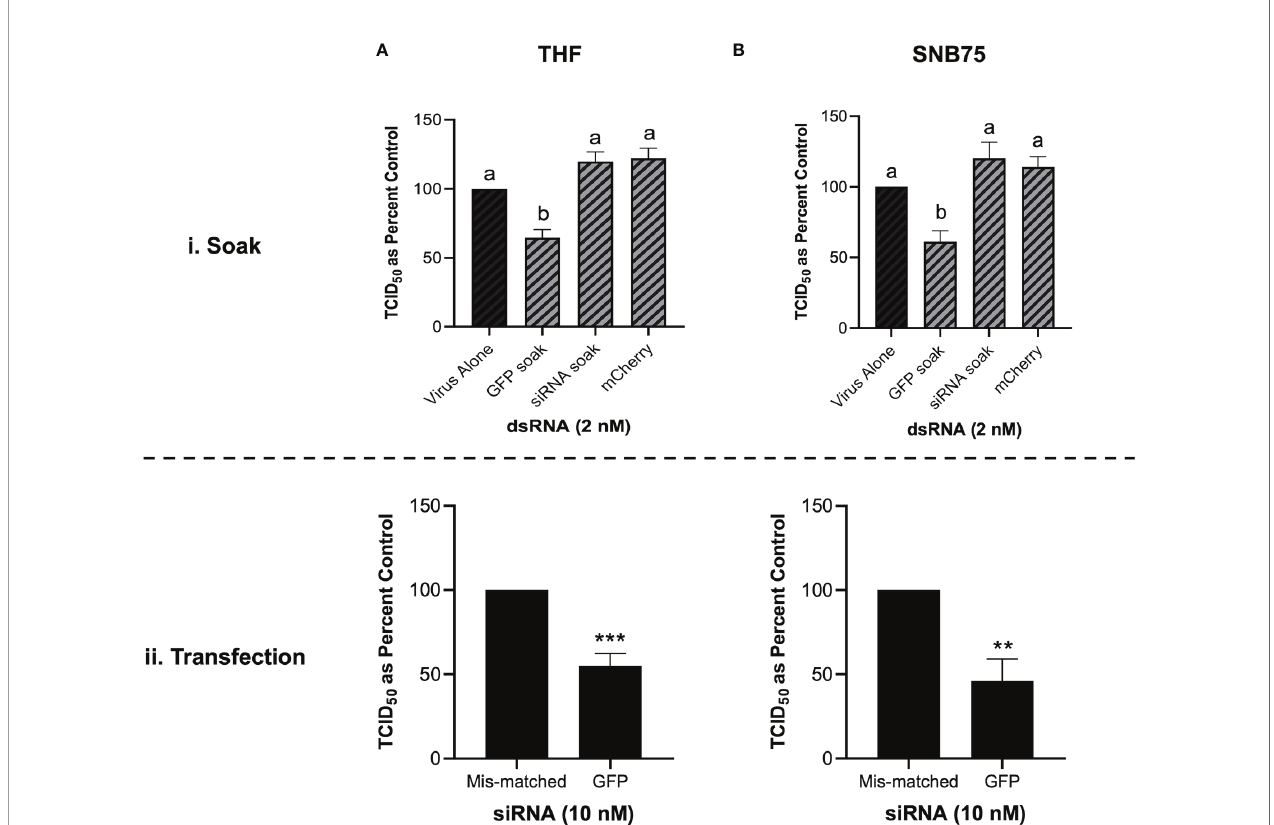
FIGURE 6 | Soaking is suf fi cient for long dsRNA-induced antviral effects but not siRNA. THF (Ai) and SNB75 (Bi) were pre-soaked for 2h with either DPBS, 2 nM of long mCherry dsRNA, 2 nM of long GFP dsRNA or 2 nM of GFP siRNA prior to infection with VSV-GFP (MOI = 0.1) for 24h. To ensure that the siRNA was functional, THF (Aii) and SNB75 (Bii) cells were transfected with either 10 nM of GFP siRNA or 10 nM of the negative control siRNA for 24h prior to infection with VSV-GFP (MOI = 0.1) for 24h. Error bars represent +SEM, and each data point represents the average of 5 independent replicates. A p-value of less than 0.05 was considered to be statistically signi fi cant and different letters represent signi fi cant differences. For the transfection data, a p-value of less than 0.01 is represented by a ** symbol while less than 0.001 is represented by a ***